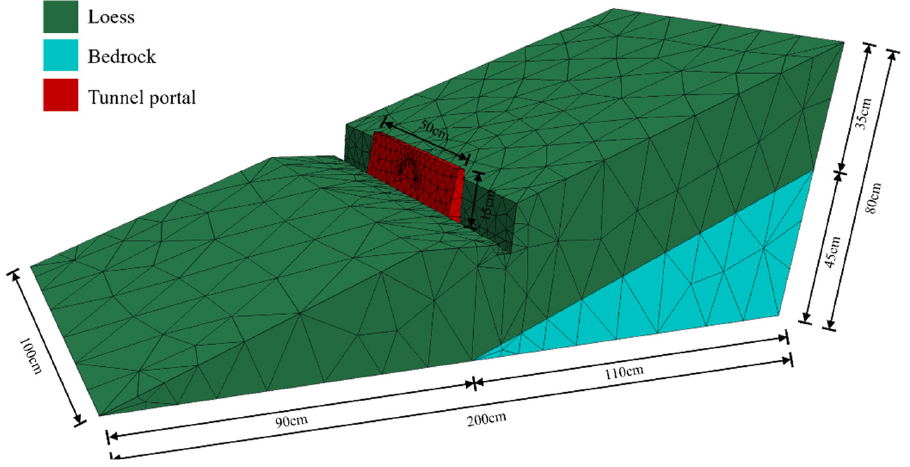
Figure 4. Numerical modeling of the test model at a 1:1 ratio.